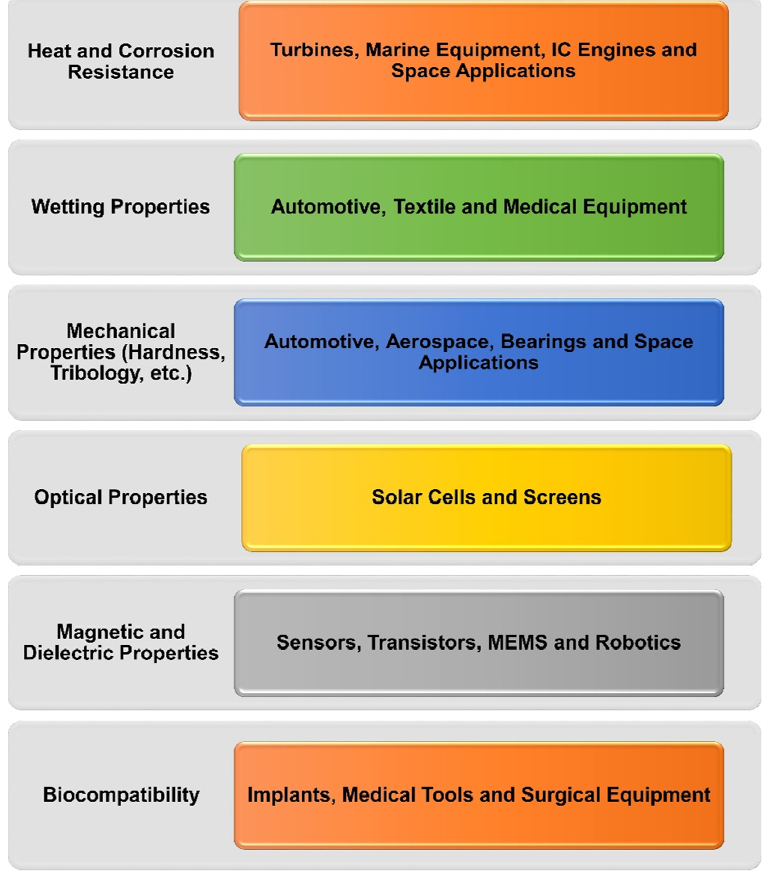
Figure 19. Application areas of nanostructured coatings [225].